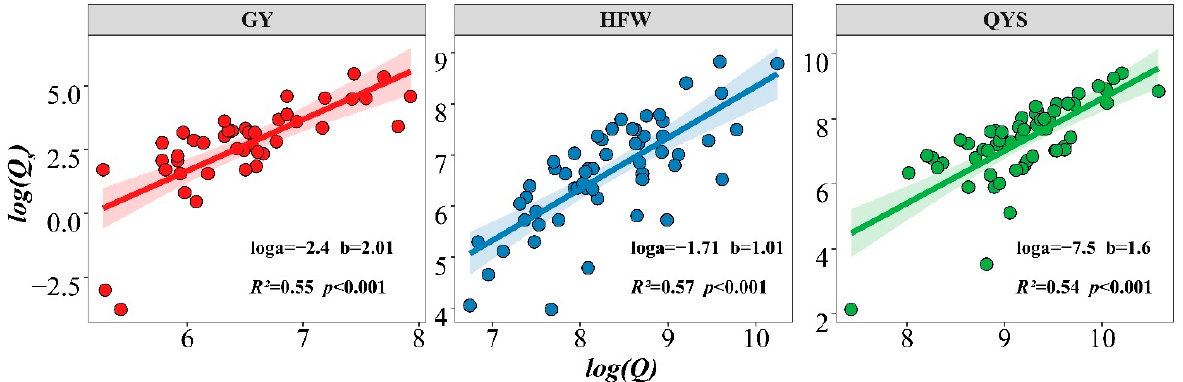
Figure 7. SRCs at three hydrological stations with annual records during 1960–2016 (shown in Table